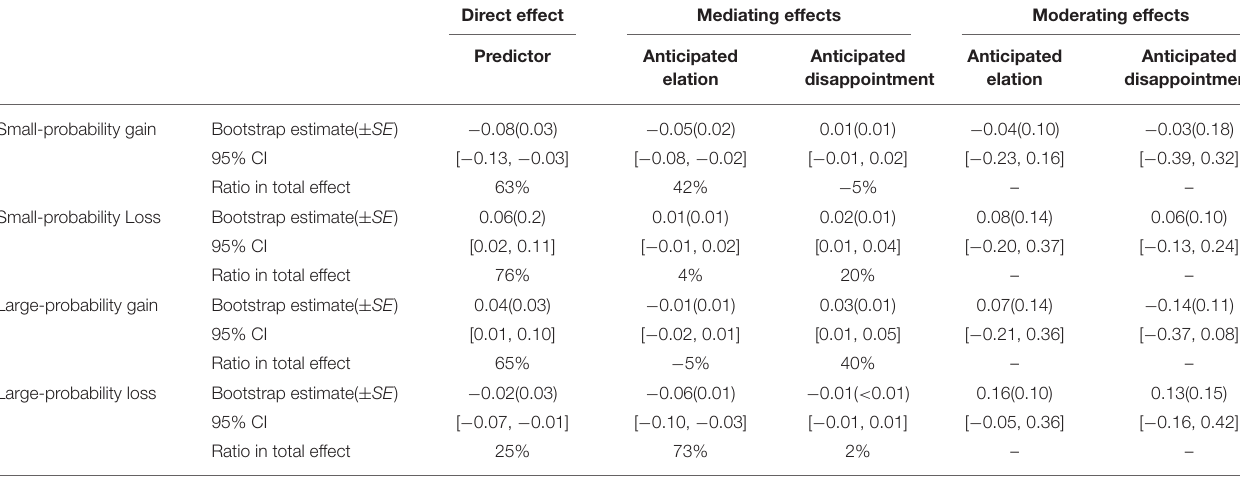
TABLE 3 | Direct and indirect effects in the path